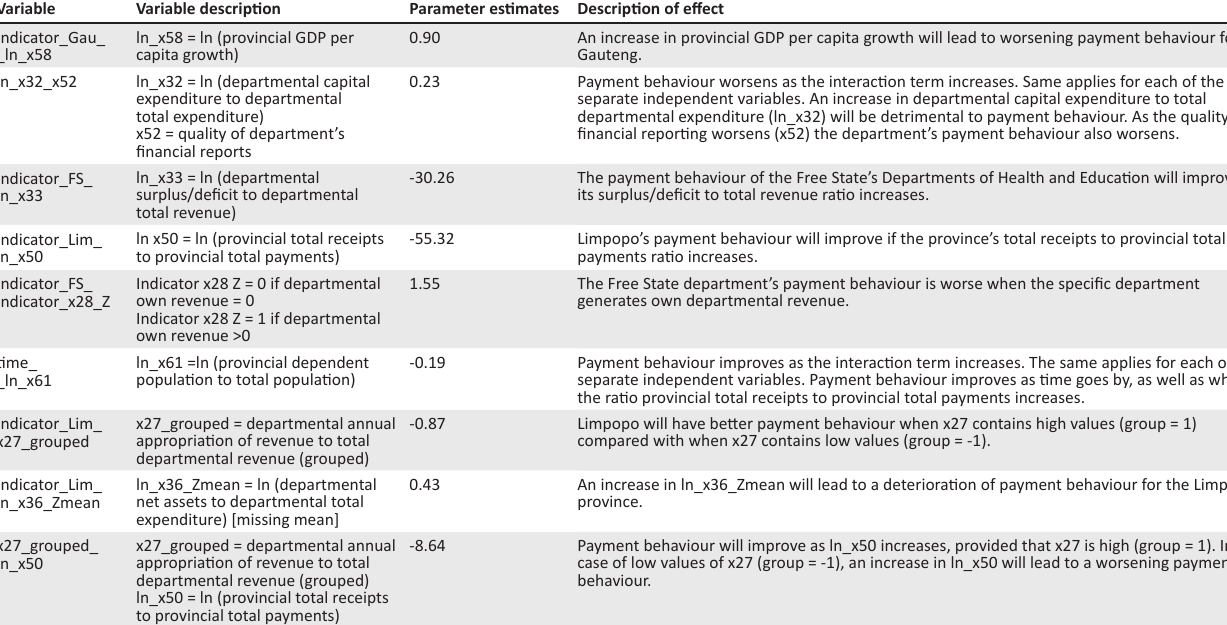
TABLE 2: Details of the Generic Advanced Model 1 . Variable Variable description Parameter estimates Description of